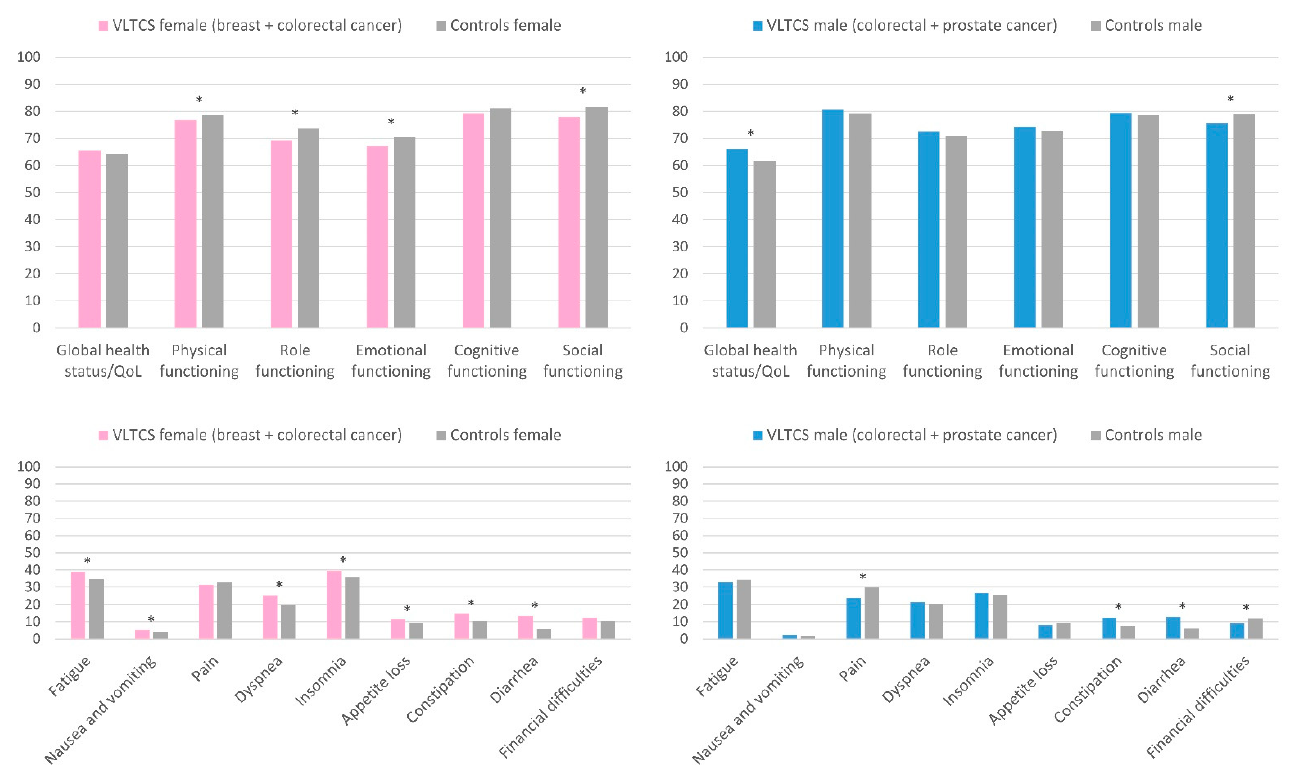
Figure 5. EORTC QLQ-C30 global health status/QoL, functioning scores, and symptom items and scores of female long- term cancer survivors compared with female controls and of male long-term cancer survivors compared with male controls, adjusted for age and education. VLTCS, very long-term cancer survivors (recruited via population-based cancer registries). Asterisks (*) mark statistically significant subgroup differences ( p < 0.05).